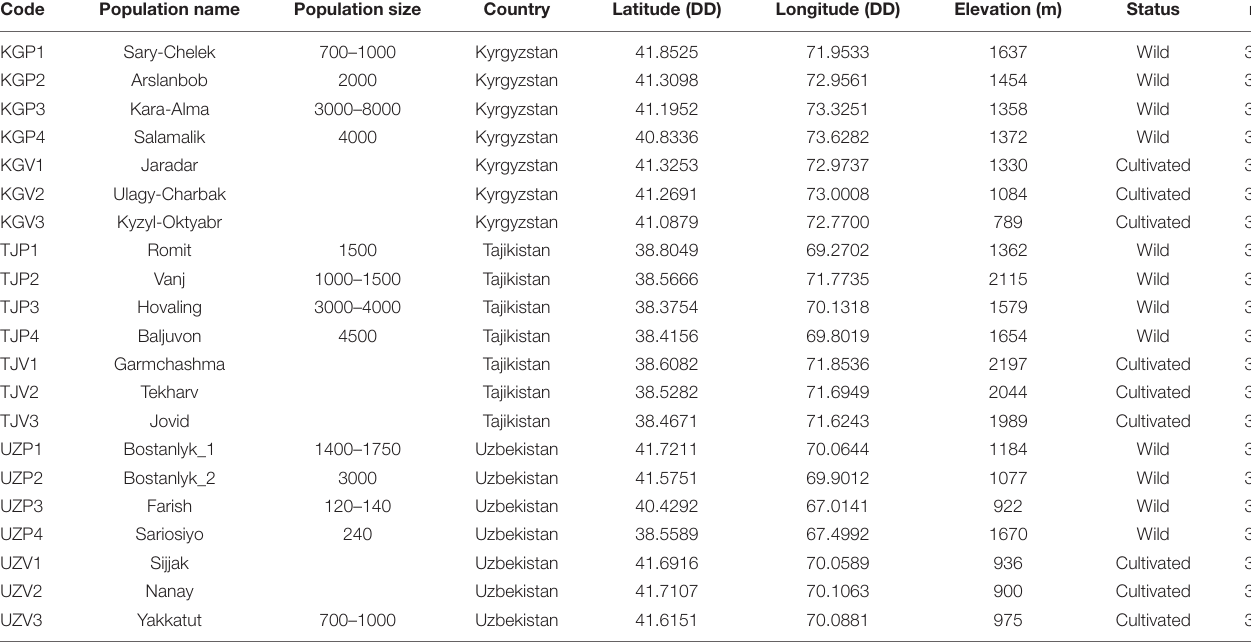
TABLE 1 | List of 21 Juglans regia L. populations analyzed in this